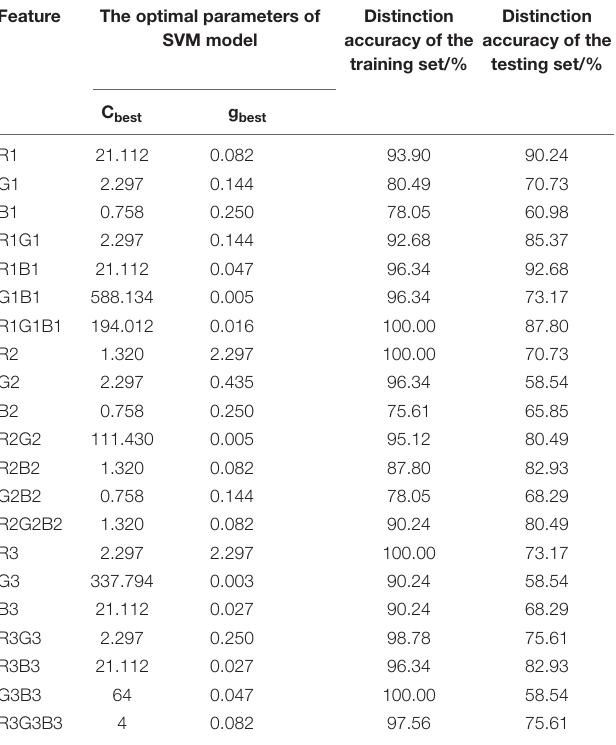
TABLE 2 | Distinction results of the SVM models based on the LBP histogram features of the gray images of the three components in RGB color space of the segmented lesion images.